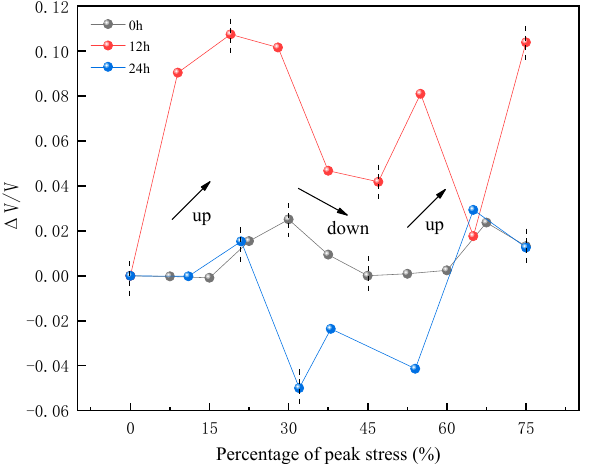
Figure 14. Coda wave velocity variation rate of LCTB with different filling interval time.